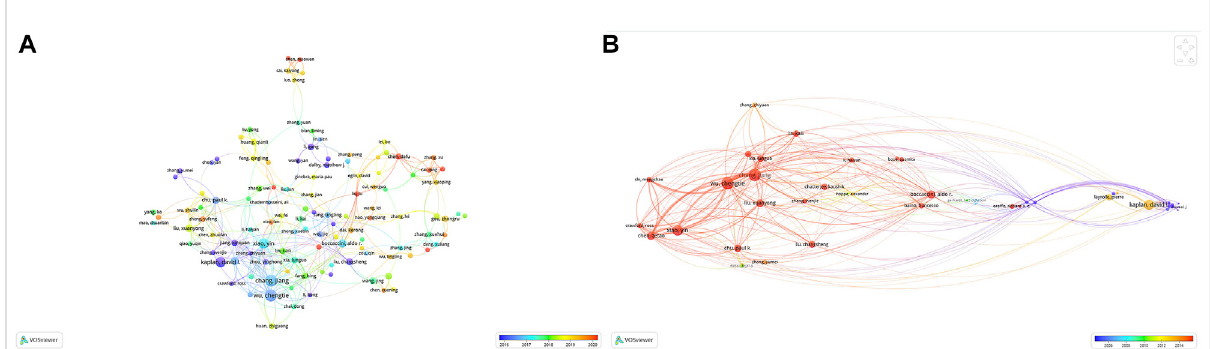
FIGURE 5 Thedistributionofauthorsinbiomaterialsresearchinosteogenesis. (A) Authorco-authorshipoverlayvisualizationmap.Thecolorofeachcircle correspondstotheaveragepublicationyearoftheauthor,thesizeofacircleisproportionaltothenumberofliteraturespublishedbytheauthor,and the thickness of the connecting line indicates the cooperation frequency. (B) Author co-citation overlay visualization map. The color of each circle corresponds to the average publication year of the author, the size of a circle is proportional to the total number of citations of the author, and the thickness of the connecting line indicates the strength of the co-citation